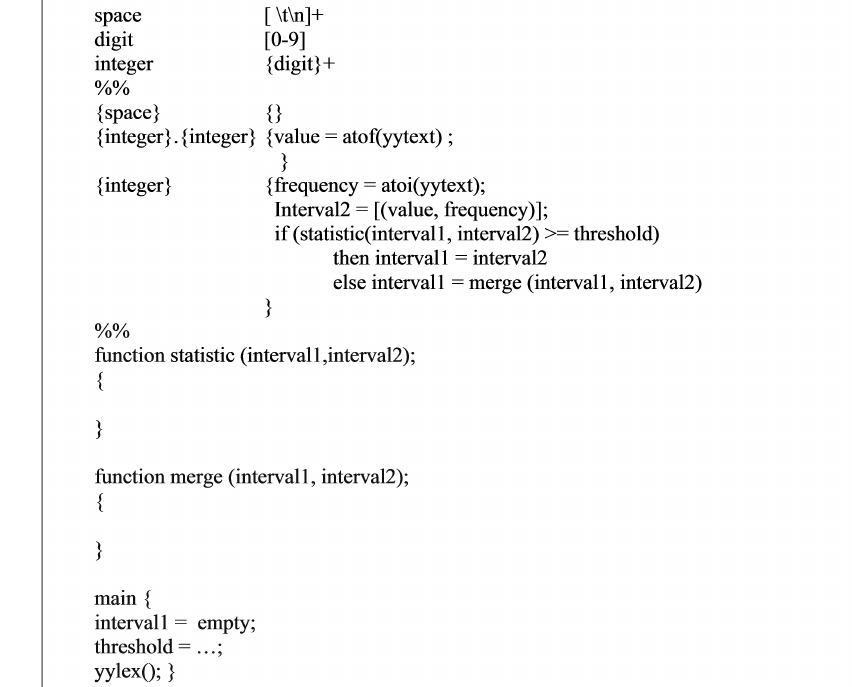
Fig. 3. The Lex source for generating the discretization